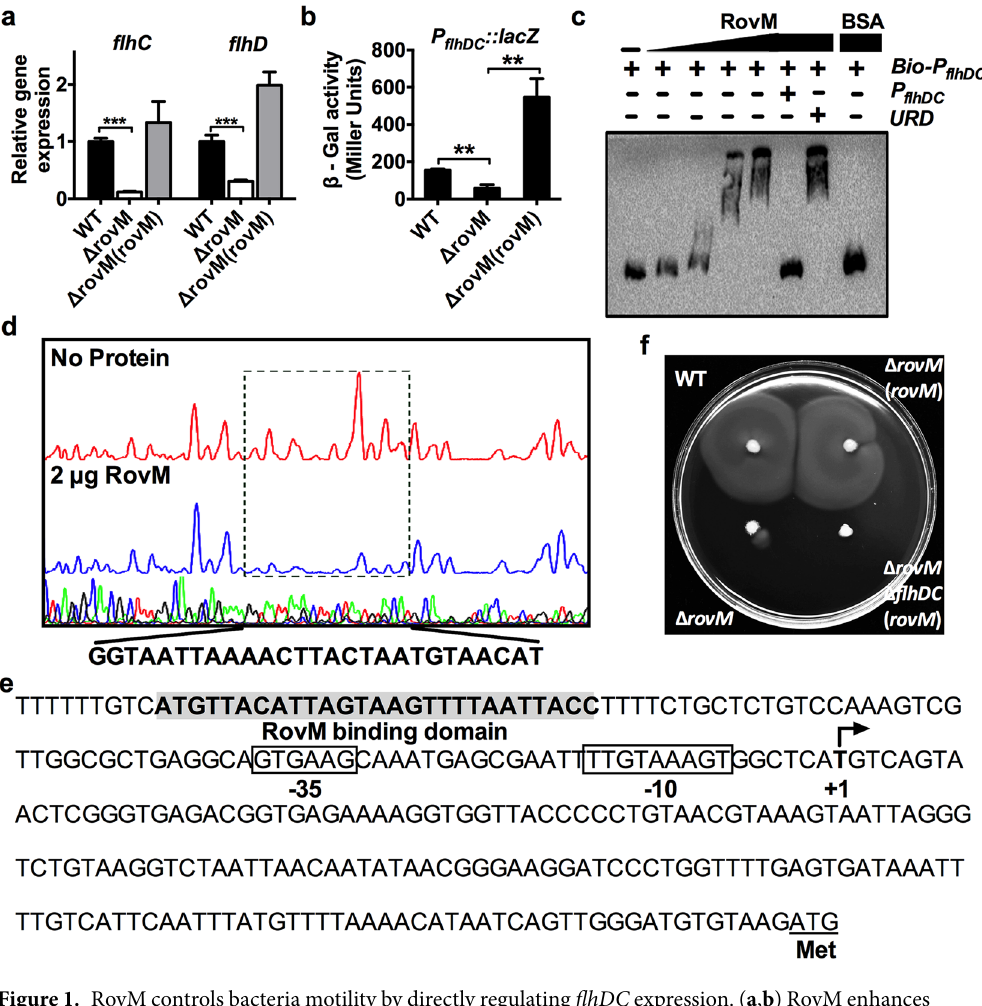
Figure 1. RovM controls bacteria motility by directly regulating flhDC expression. ( a , b ) RovM enhances the expression of the flhDC operon. The relative expression measured by quantitative RT-PCR ( a ) or the β -galactosidase activity ( b ) in the indicated bacterial strains was determined. ( c ) RovM binds the flhDC promoter. Biotin-labelled probe, unlabelled probe or an unrelated fragment was incubated with RovM [0, 0.13, 0.27, 0.54 and 0.108 µ M] or BSA [5 µ M]. The protein-DNA complexes were detected by streptavidin-conjugated HRP and chemiluminescent substrate. Unlabelled promoter was added to determine the binding specificity of RovM. Bio-P flhDC : biotin-labelled flhDC promoter; P flhDC : unlabelled flhDC promoter; URD: unrelated fragment (uncropped version was shown in Fig. S4a). ( d ) Identification of the RovM-binding site within the flhDC promoter using a DNase I footprinting assay. ( e ) Nucleotide sequence of the flhDC promoter region. Putative − 35 and − 10 elements of the flhDC promoter are boxed. + 1 denotes the transcription start point. The RovM-binding site identified with the DNase I footprinting assay was indicated by shading. ( f ) Motility of the Y. pseudotuberculosis YPIII, Δ rovM mutant, Δ rovM ( rovM ) and Δ rovM Δ flhDC ( rovM ) strains on semi- solid plates. Data shown are the average of three independent experiments; error bars indicate SD from three independent experiments. ** P < 0.01; *** P <